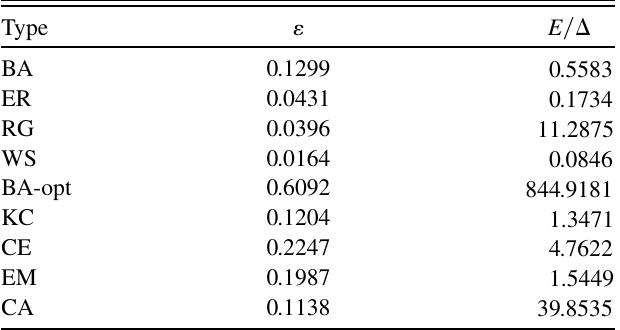
TABLE I. Quantumness, energy, and gap. We show the quan- tumness " and its upper bound E= (cid:2) (the ratio of the energy and the gap), for each of the nine networks considered in Fig.